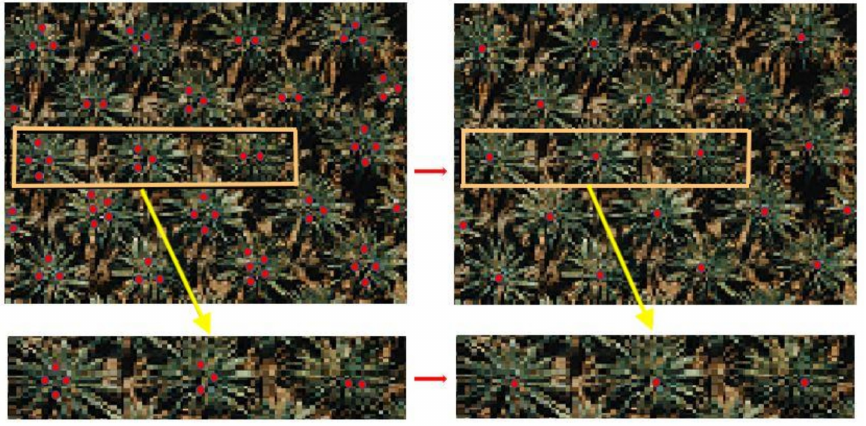
Figure 4. Estimation of tree count using sample merging